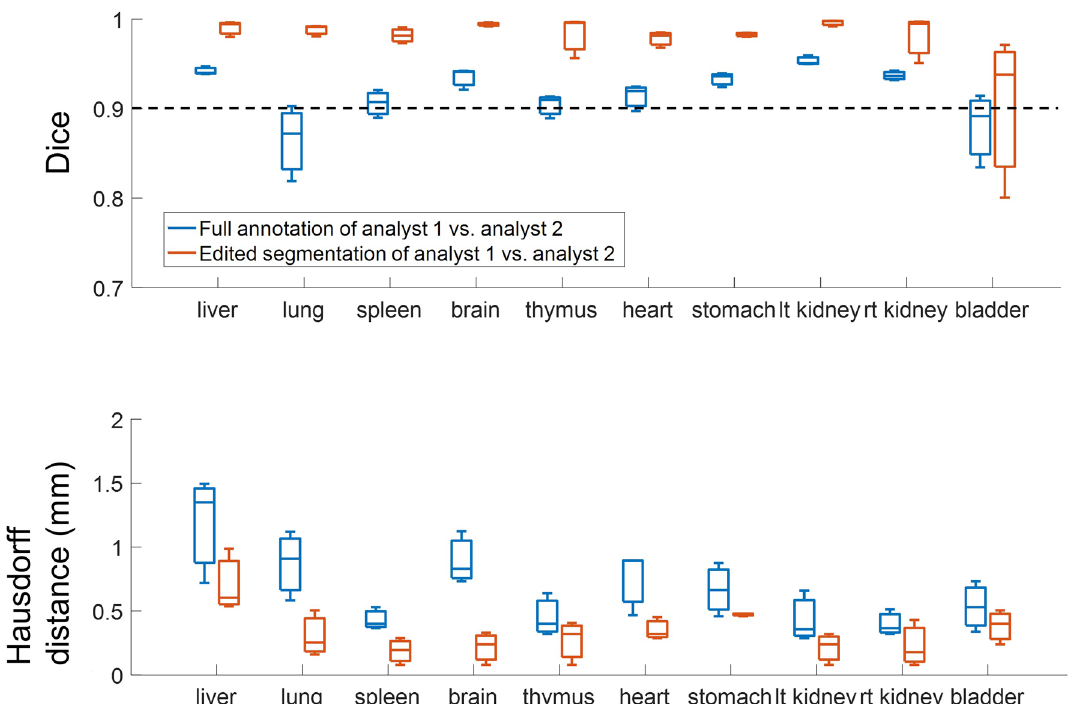
Figure 8. Comparison of Analyst 2 versus the more experienced Analyst 1. Comparison of Analyst 2 versus Analyst 1 with manual segmentation (blue) and with editing of deep learning segmentation (red). Ten organs were evaluated in three mice. Dice scores improved for each organ with editing of the deep learning result, as compared with fully manual segmentation (top). The HDs were similarly improved, with lower values indicating improved segmentation (bottom). In addition to improved reproducibility, the editing approach greatly reduced editing time, compared with a fully manual analysis (see